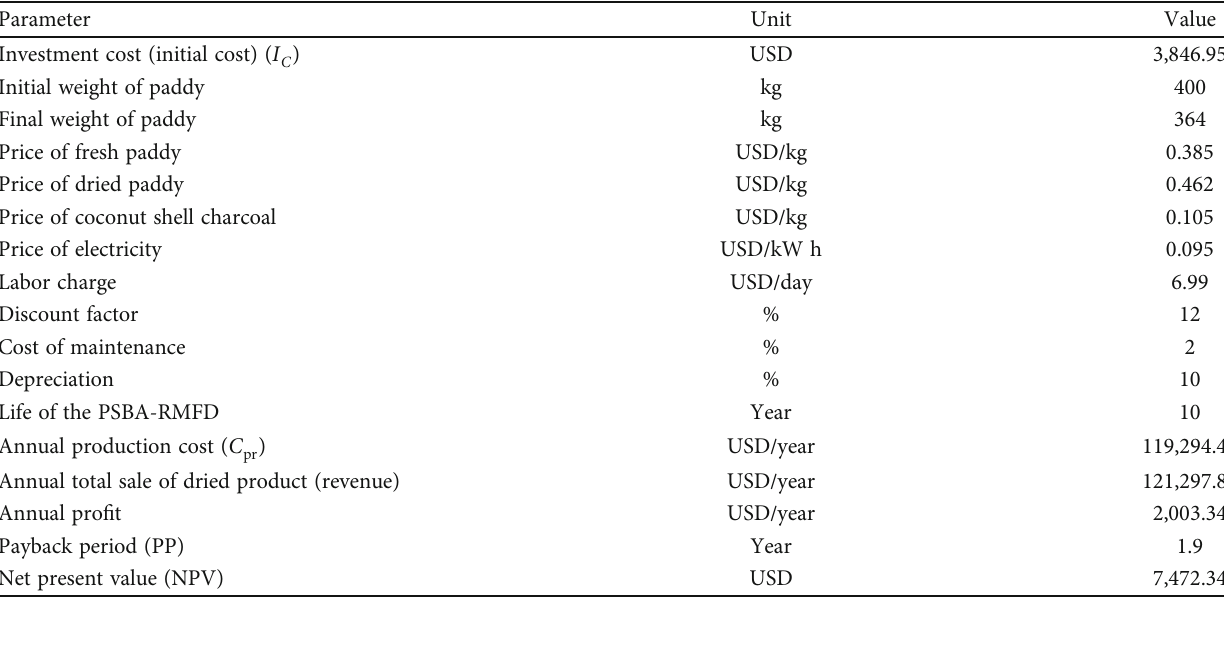
Table 9: Economic evaluation of PSBA-RMFD.